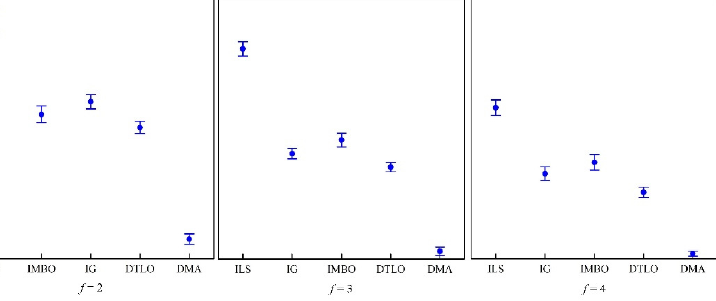
Figure 9. Mean plot with 95% confidence interval of the compared algorithms on different scenarios.